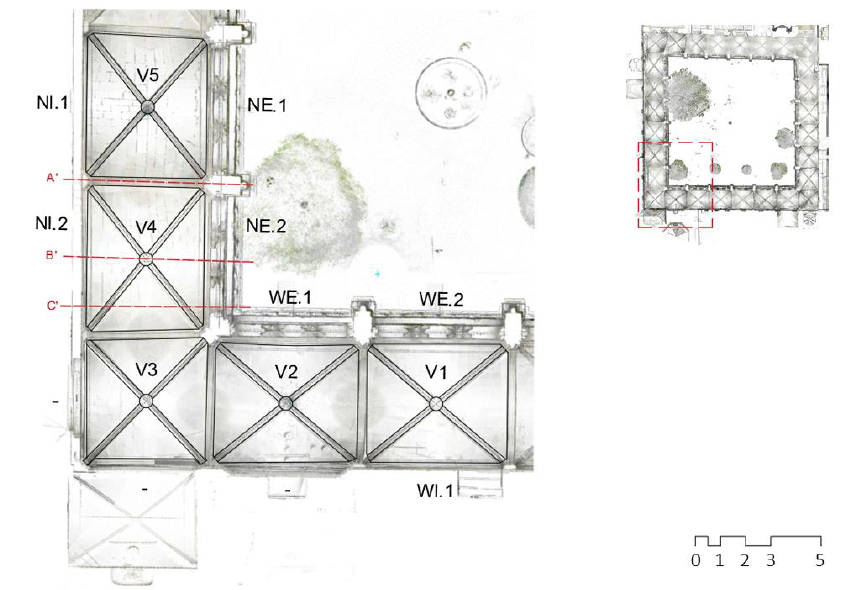
Figure 3. Nomenclature used for vaults and walls.